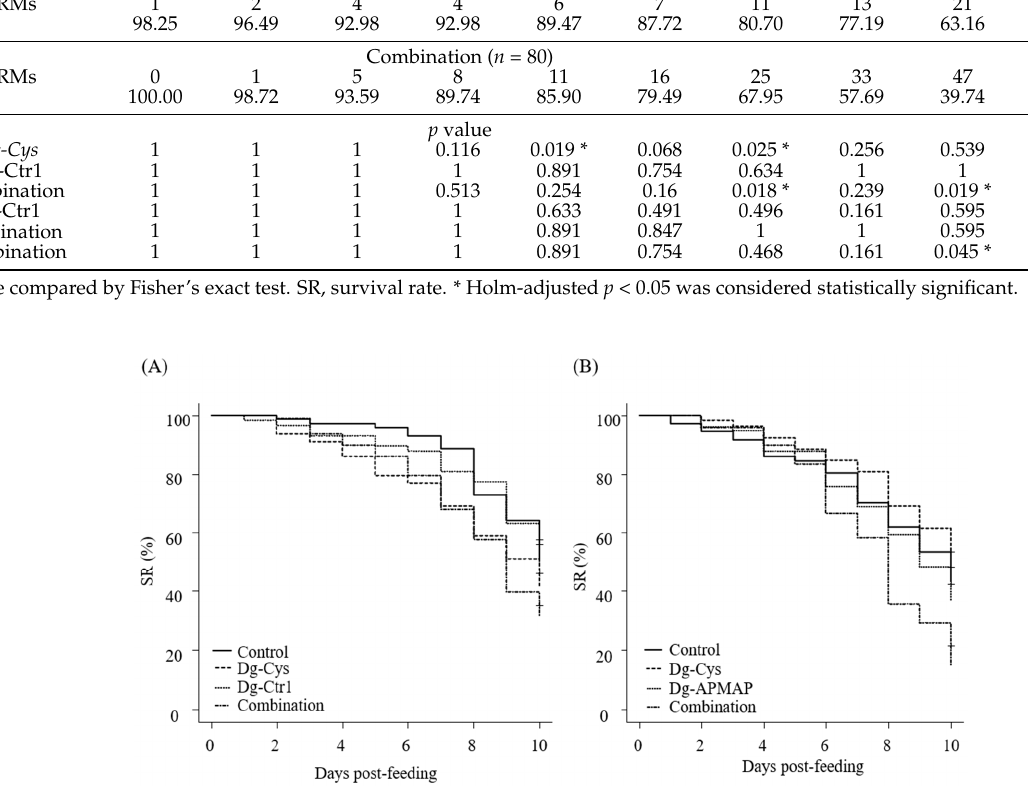
Figure 6. Acaricidal effects of combined immune plasmas on adult mites. The efficacies of “cocktail vaccine” on adult mites were evaluated in vitro. The survival rate (SR) of adult PRMs that were fed with the combined plasmas derived from ( A ) Dg-Cys - and Dg-Ctr1-immunized chickens and ( B ) Dg-Cys - and Dg-APMAP-immunized plasmas was assessed every day for a ten-day period.